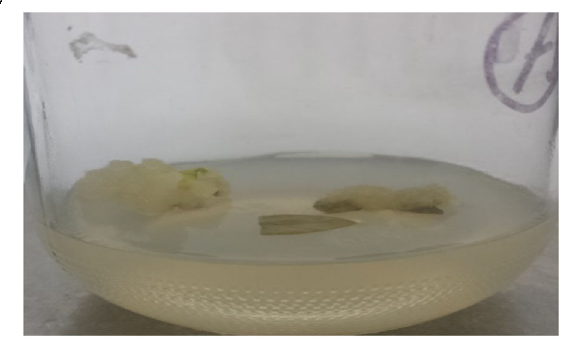
Fig. 1 Induced calli of gardenia leaf explants grown on MS medium containing 0.5 mg/l BA + 0.5 mg/ l Picloram